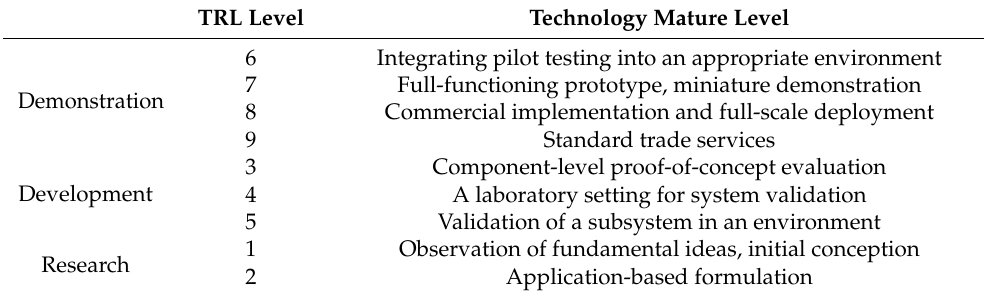
Table 11. Stages of TRL development as defined by EPRI. Source: adapted from Freeman and Bhown (2011)